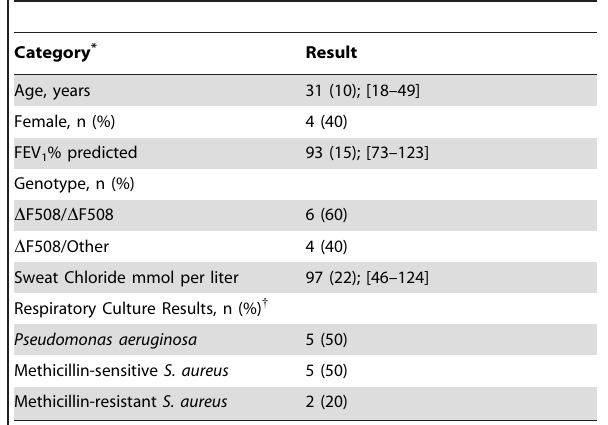
Table 1. Baseline Characteristics of the Study Cohort (n=10).